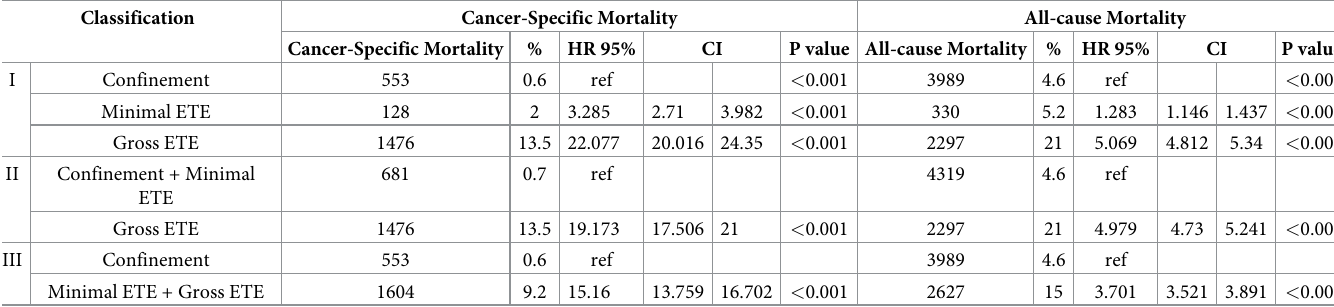
Table 2. Cancer-specific mortality and all-cause mortality according to different extent of tumor extension. Classification